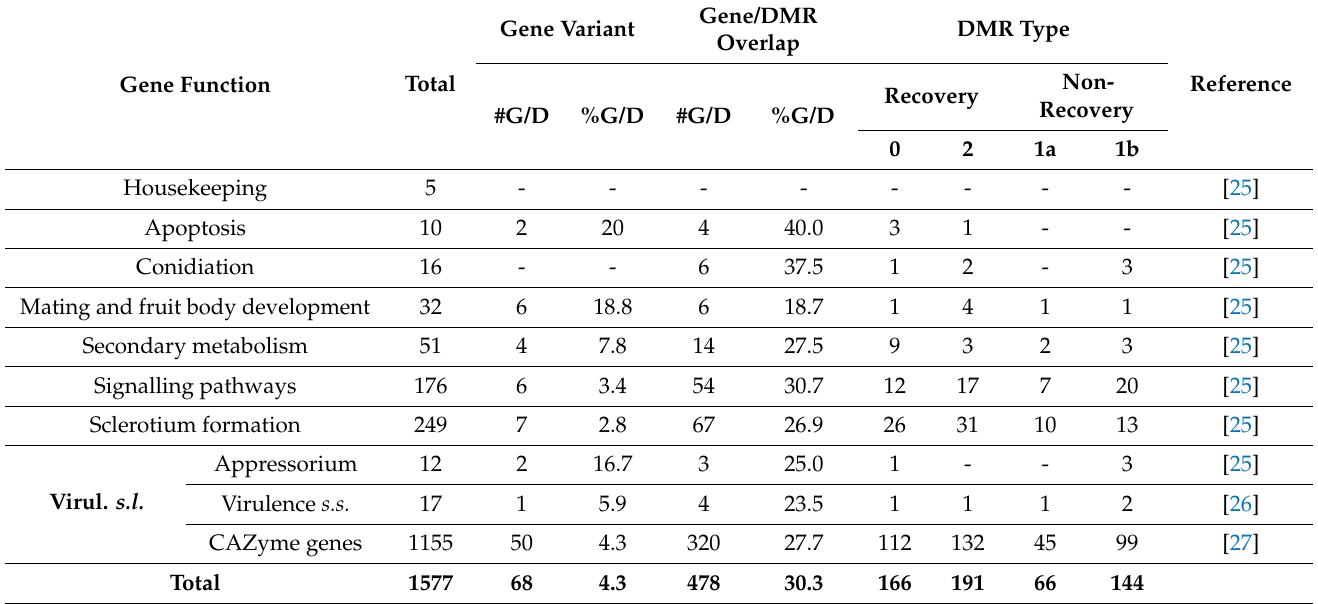
Table 1. Botrytis cinerea genes with known function presenting a sequence variant and/or overlapping with in vitro culture-induced DMRs. Columns that Gene Variant and Gene/DMR overlap indicate the number (#) and percentage (%) of genes in each functional group with a genetic variant or overlapping with a differentially methylated region, respectively. Column DMR type indicates how methylation levels changed when comparing all three samples (T1, T8 and T8P). DMRs were grouped according to their changing patterns into recovery (T1 = T8P) and non-recovery (T1< >T8P). Two subgroups were found for recovery (T1 = T8P < T8 (Type 0) and T1 = T8P > T8 (Type 2)) and non-recovery (T1 > T8 = T8P (Type 1a) and T1 = T8 < T8P (Type 1b)). Virul. s.l. indicates virulence genes